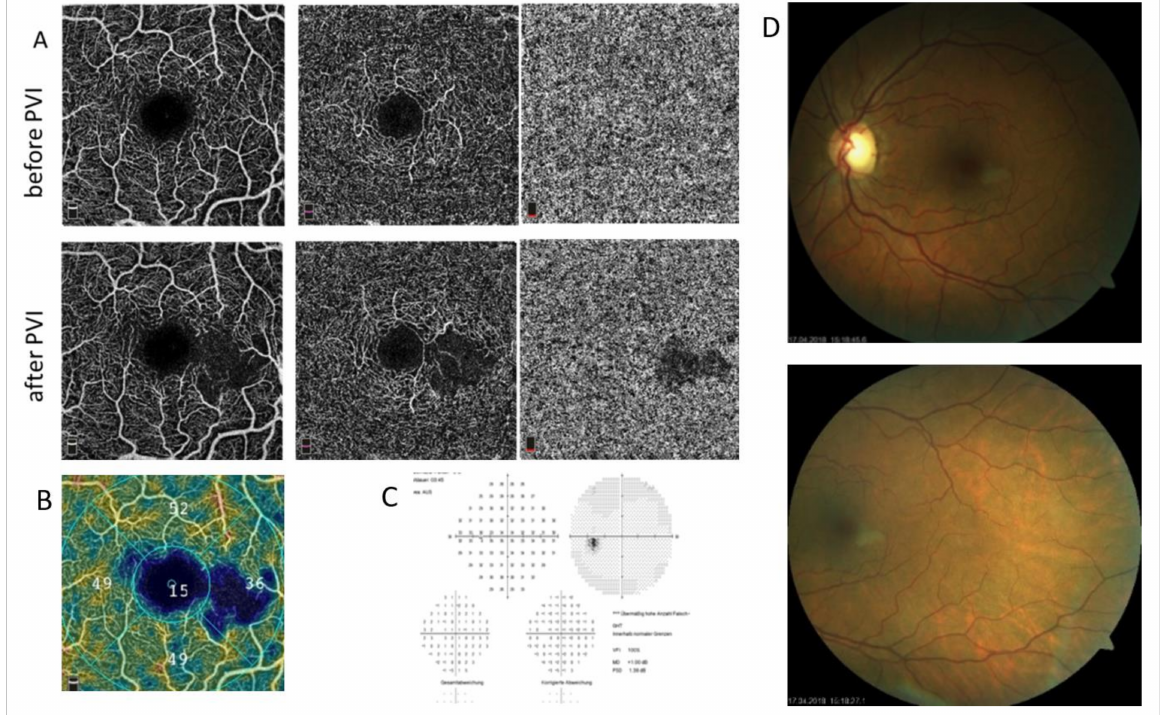
Figure 1. ( A – D ): Silent retinal microinfarction in a patient after PVI. ( A ): superficial and deep OCT angiogram of the macula before and after PVI. ( B ): Color-coded OCT angiogram of the macula showing the reduced FD temporal of the foveal avascular zone. ( C ): Visual field after PVI without significant defects. ( D ): Fundus photography images showing the small retinal edema. OCT = optical coherence tomography, PVI = pulmonary vein isolation, FD = flow